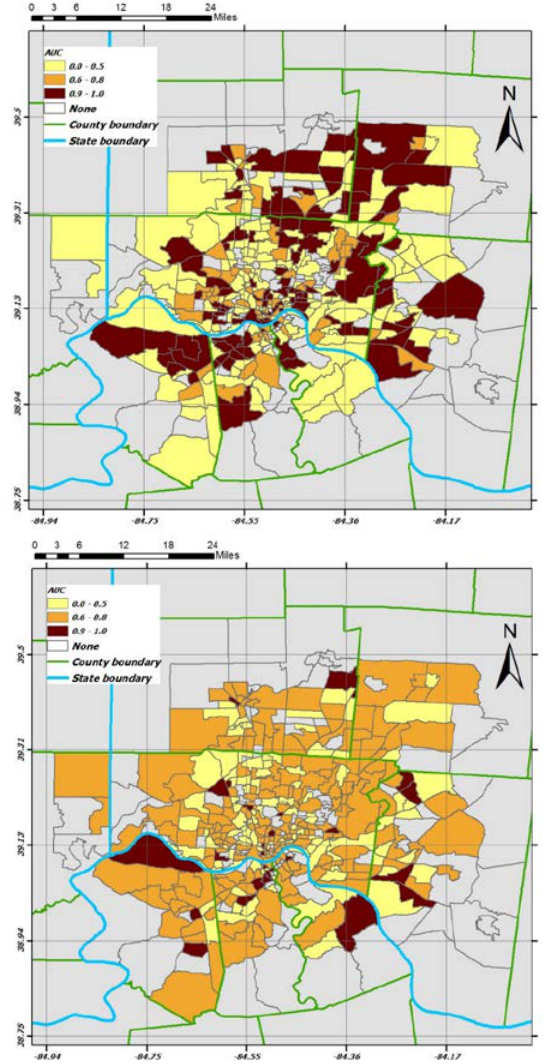
Figure 8. The spatial distribution of AUC values of Tweets based (top) and survey based (bottom) test data